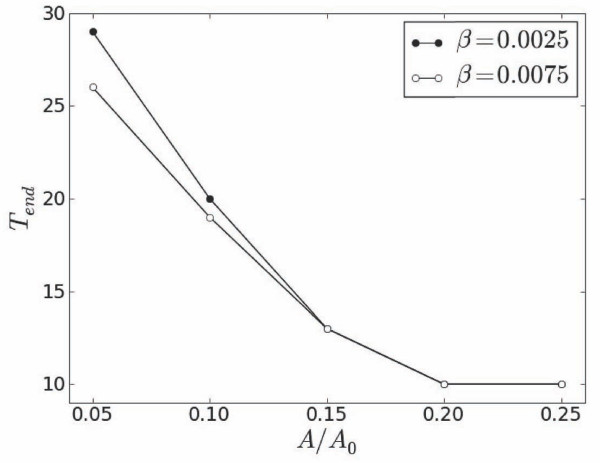
Dependence of Tend on AA0 for two values of β at x=L2.